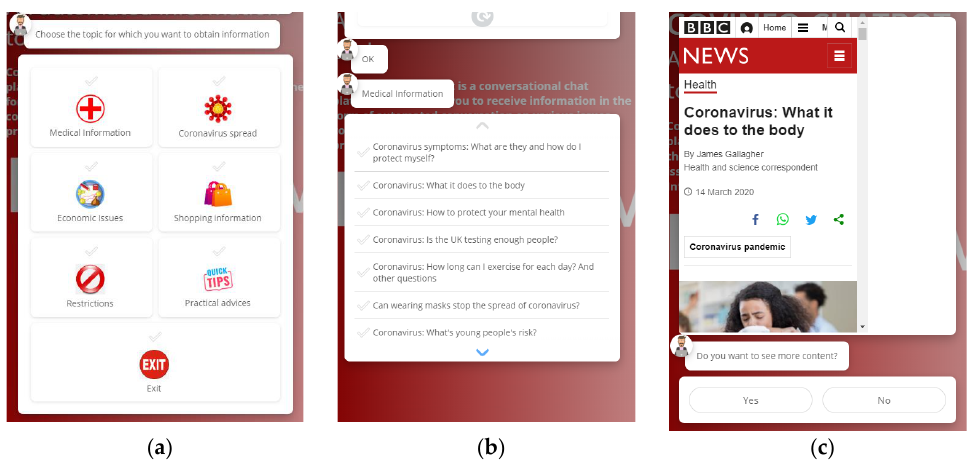
Figure 4. Screenshots of contents (a), available discussion topics (b) and articles (c) in the COVINFO Reporter chatbot.